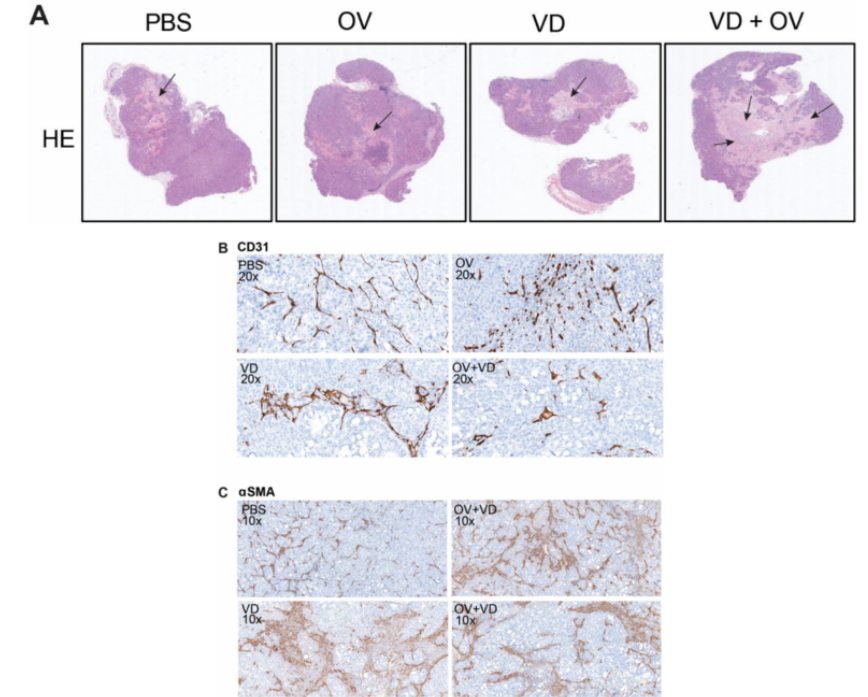
Figure 4. VD analogue (VD) enhances tumor necrosis and alters tumor fibrosis and vasculature. Hematoxylin and eosin (H&E) staining shows representative histological di ff erences between groups with black arrows marking areas of tumor necrosis. Scale bars = 500 µ m ( A ). Sections analyzed and graded by pathologist showed di ff ering intratumoral vascular density ( B ) corresponding with varied status of intratumoral stromal cells ( C ).